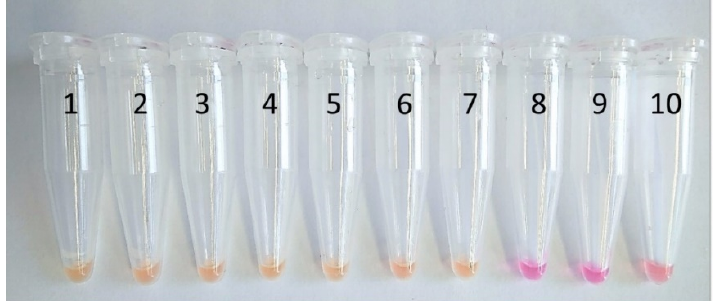
Figure 3. Results of the WarmStart Colorimetric LAMP 2X Master Mix assay for detection of LAMP amplicons with the naked eye. Samples 1–8: serial dilutions of DNA from strain G. ( H.) parasuis DSM 21448 starting at concentrations of 10 ng/ µ L up to 1 fg/ µ L. Sample 9: DNA from Actinobacillus minor CCUG 38923 T . Sample 10: no template